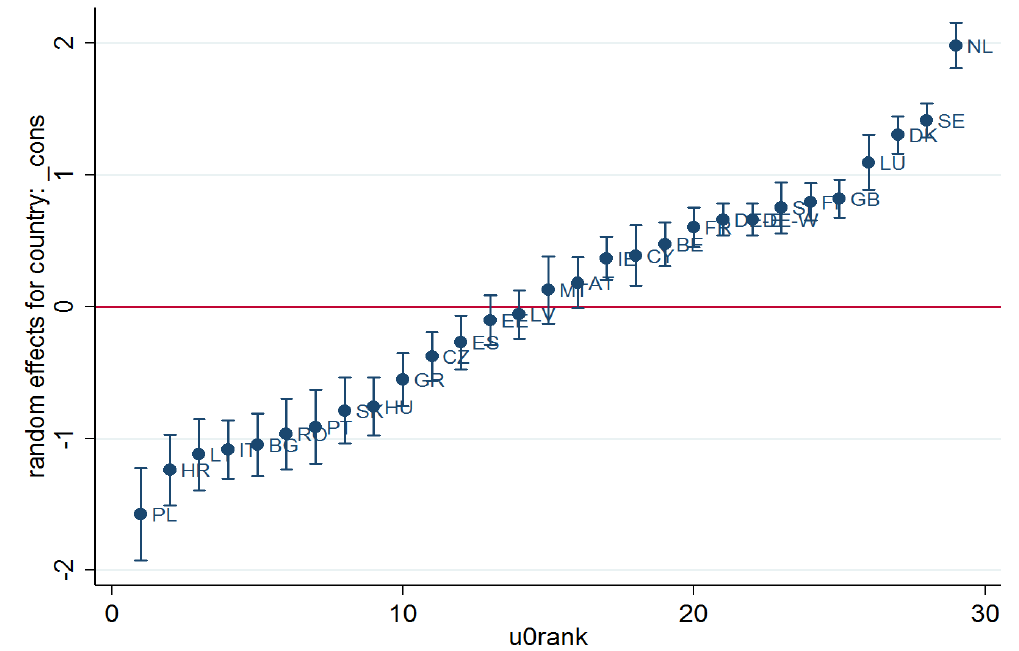
Figure A2. Country-level effects of null model of extra mitigation behaviour. Source: Author’s contribution.